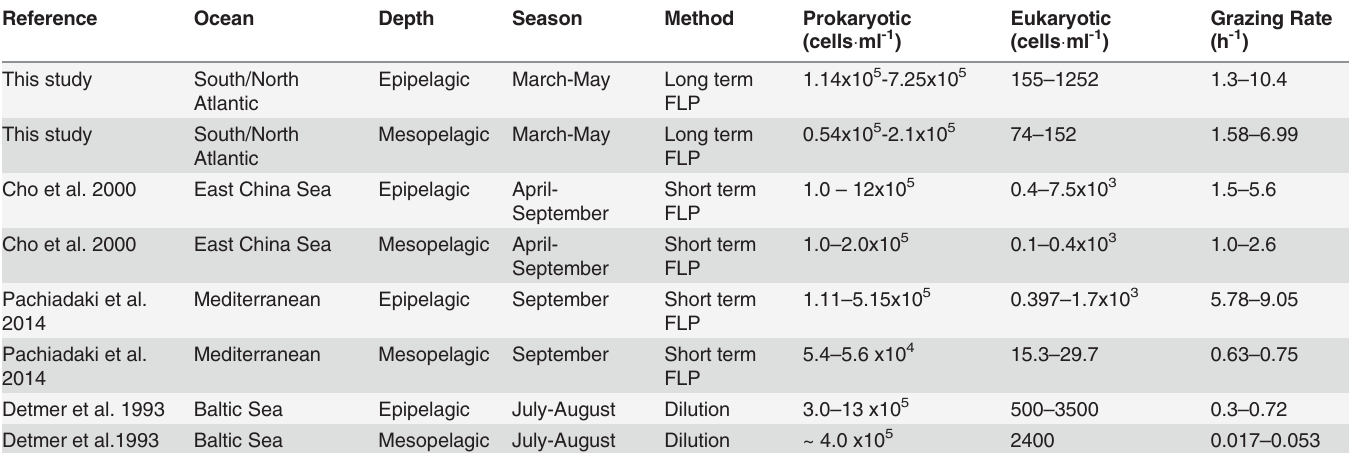
Table 3. Prokaryote and eukaryote counts and grazing rates reported in the euphotic zone and mesopelagic from different studies.